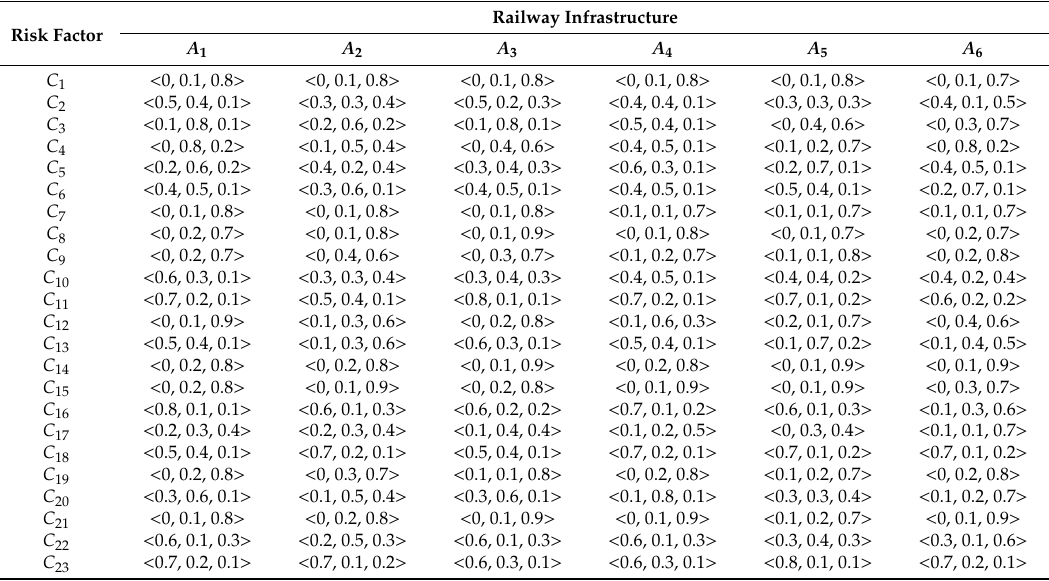
Table 6. The picture fuzzy evaluation matrix.